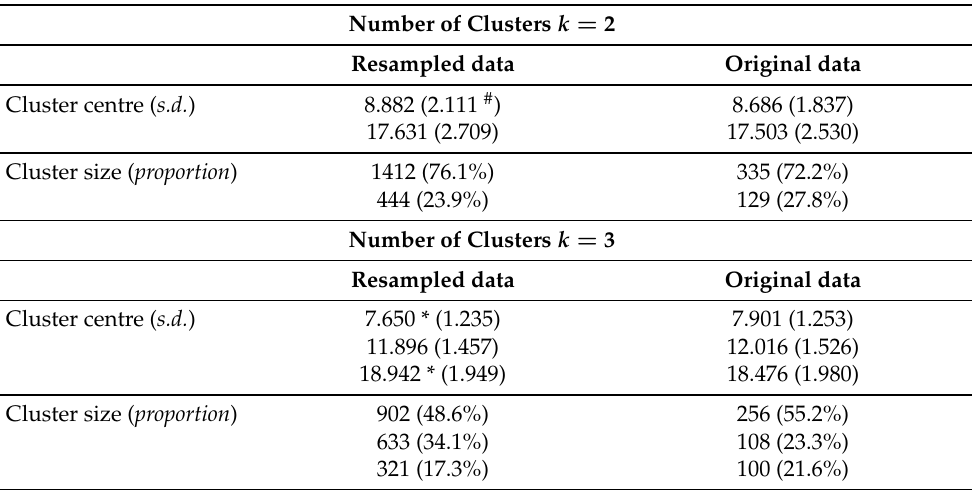
* Sample means are statistically different between groups at the 5% significance level. # Sample standard deviations are statistically different between groups at the 5% significance level. Details of statistics and associated p values for comparing group means and variances in given in Table A1 in Appendix